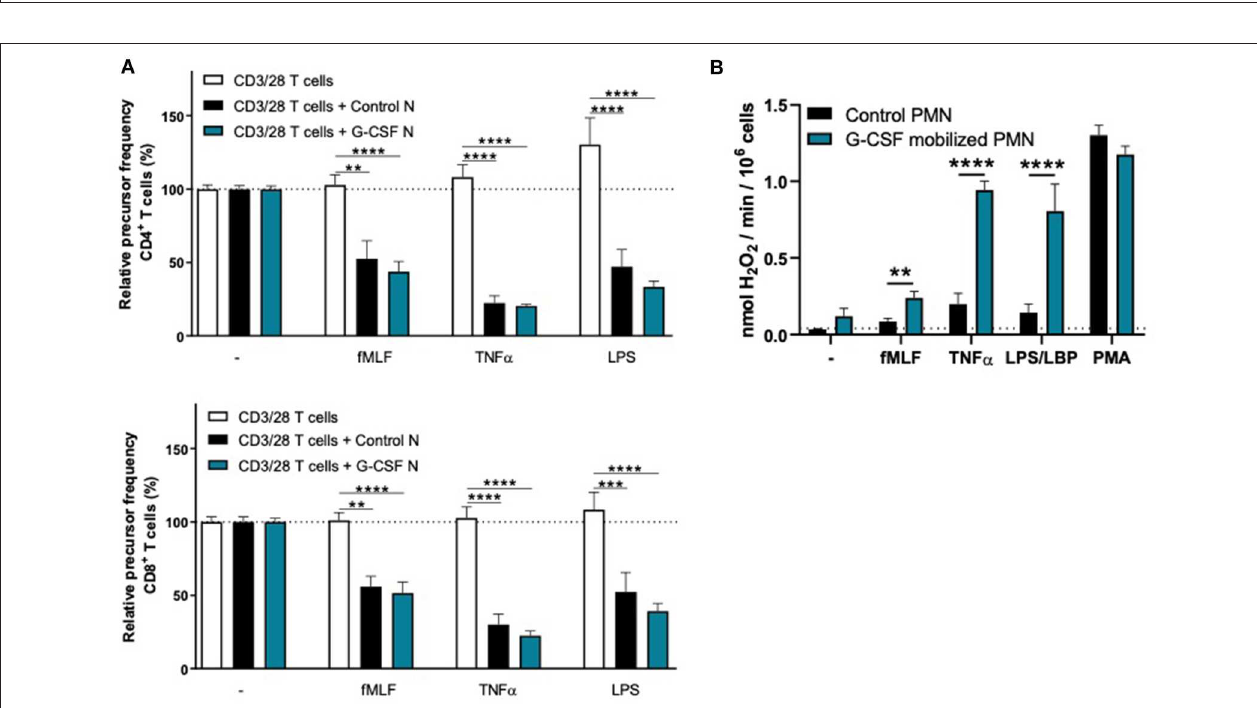
FIGURE 4 | G-CSF-mobilized neutrophils can suppress the T cell proliferation and have an elevated respiratory burst. (A) Purified CFSE-labeled T cells from healthy donors ( n = 6) were cultured in absence (white bars) or presence of mature neutrophils from control donors (black bars, n = 6), or G-CSF-mobilized neutrophils (blue bars, n = 3). T cells were stimulated with anti-CD3 and anti-CD28 ntibodies. Neutrophils were kept unstimulated or activated with the indicated stimuli. After 4 or 5 days, cells were harvested and analyzed by flow cytometry for CFSE dilution among CD4 + (upper graph) and CD8 + (lower graph) T cells. Error bars indicate SEM; the statistical analysis one-way ANOVA was used. (B) G-CSF-mobilized neutrophils or control neutrophils were stimulated with the indicated stimuli and production of H 2 O 2 was determined by measuring Amplex Red conversion into fluorescent Resorufin ( n = 3–6). Error bars indicate SEM; the statistical analysis unpaired two-tailed t- test was used. ** p < 0.01, *** p < 0.001, **** p <